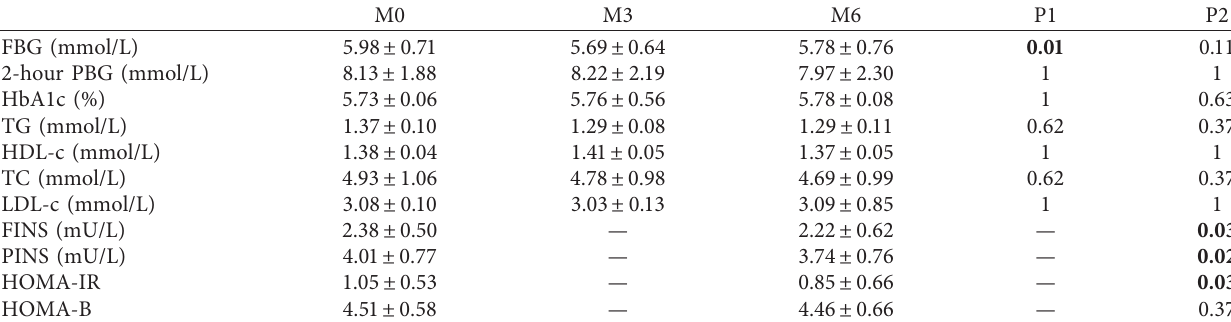
Table 1: Comparison with glucose and lipid metabolism parameters before and after inulin supplementation.